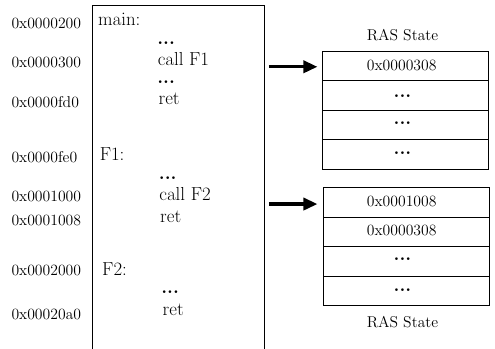
Figure 1: Example of function call and its effect on RAS.